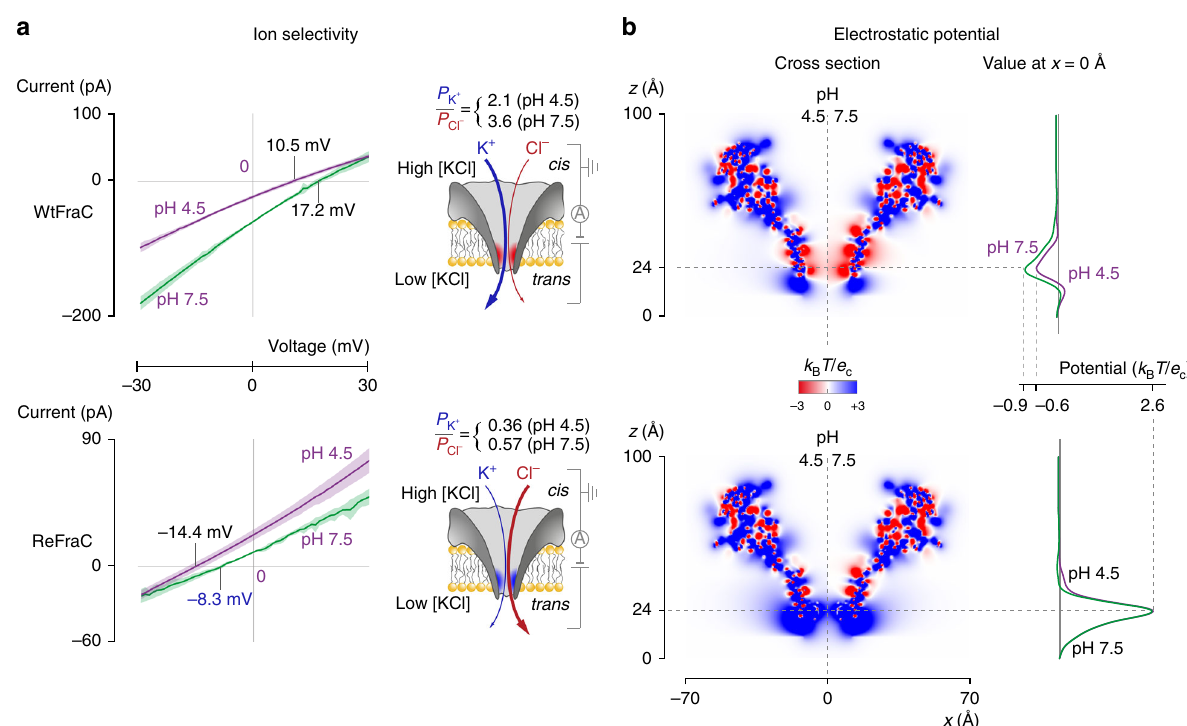
Fig. 2 Ion selectivity and electrostatic distribution of WtFraC and ReFraC. a Determination of the reversal potential shows that WtFraC and ReFraC are, respectively, cation- and anion-selective, as expected from the electrostatic potentials at their constrictions. All reversal potentials were measured under asymmetric salt conditions (467 mM KCl in trans and 1960 mM KCl in cis ) and the ion selectivity determined using the Goldman – Hodgkin – Katz equation (Eq. 1 in the main text). The buffer contained 15 mM Tris base at pH 7.5 and 100 mM sodium citrate at pH 4.5. b The averaged simulated electrostatic potentials reveal the negatively and positively charged constrictions of WtFraC and ReFraC, respectively. While for ReFraC lowering of the pH from 7.5 to 4.5 only had a small effect on the electrostatic potential, for WtFraC the peak value at the center of the constriction dropped by 37%. All simulations were performed using APBS 75 at 1 M KCl, with the partial charge of each titratable residue adjusted according to their average protonation states with a modi fi ed version of the PDB2PQR software 72 . Residue p K a values were estimated using PROPKA 78, 79 . Detailed experiment procedures are given in Methods section. The envelopes behind every current – voltage curve represent their respective standard deviations obtained from three +50 mV (Table 1; Fig. 1b), despite the reduced electrophoretic mobility toward the trans electrode.